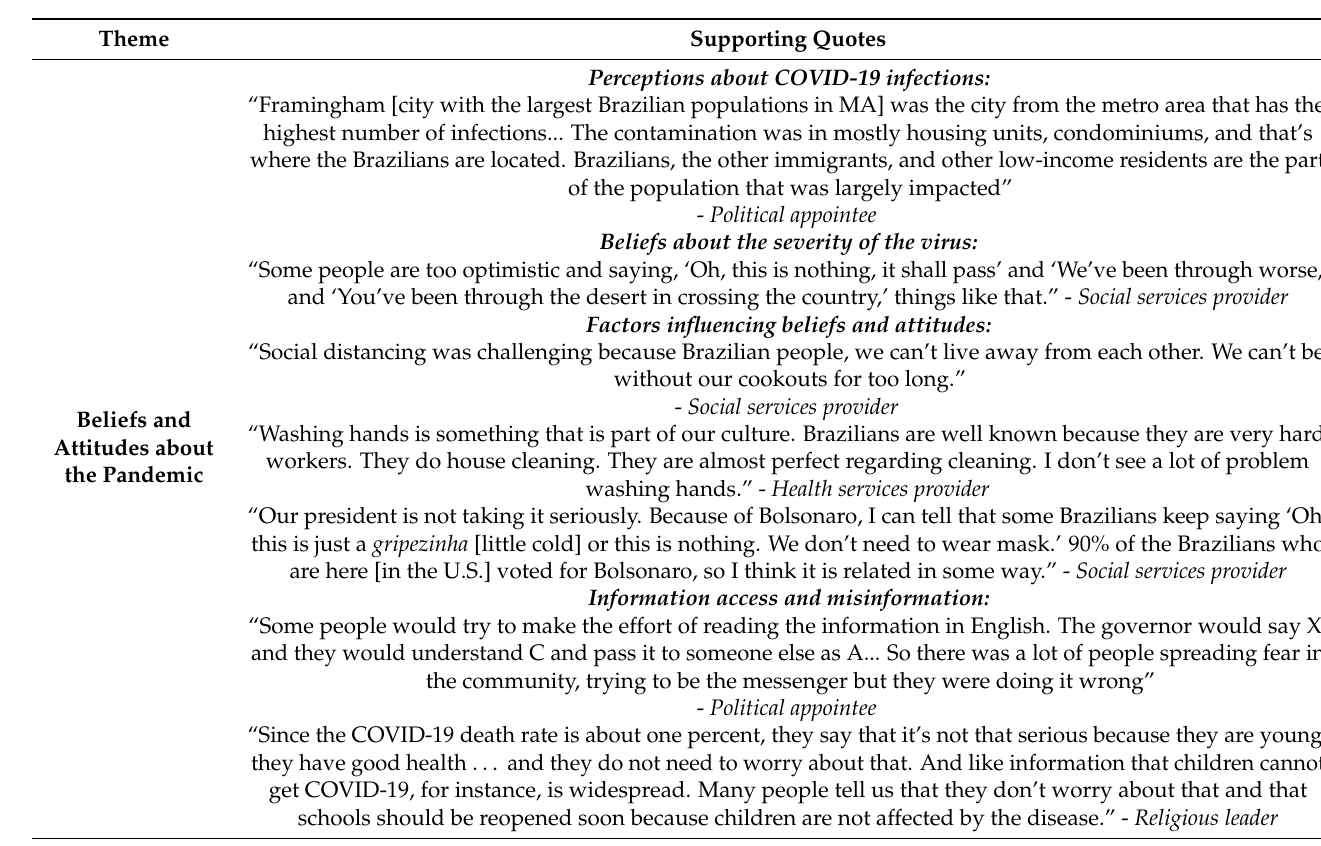
Table A2. Research Themes & Supporting